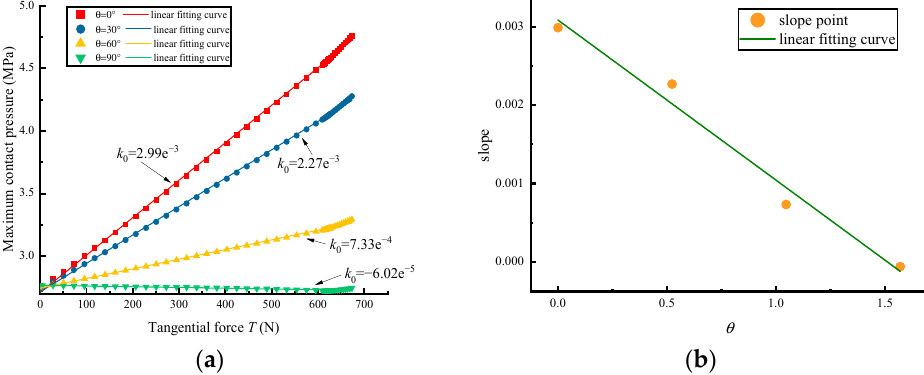
Figure 6. Variation of the peak pressure: ( a ) relationship between maximum pressure and tangential force; ( b ) relationship between k 0 and θ 0